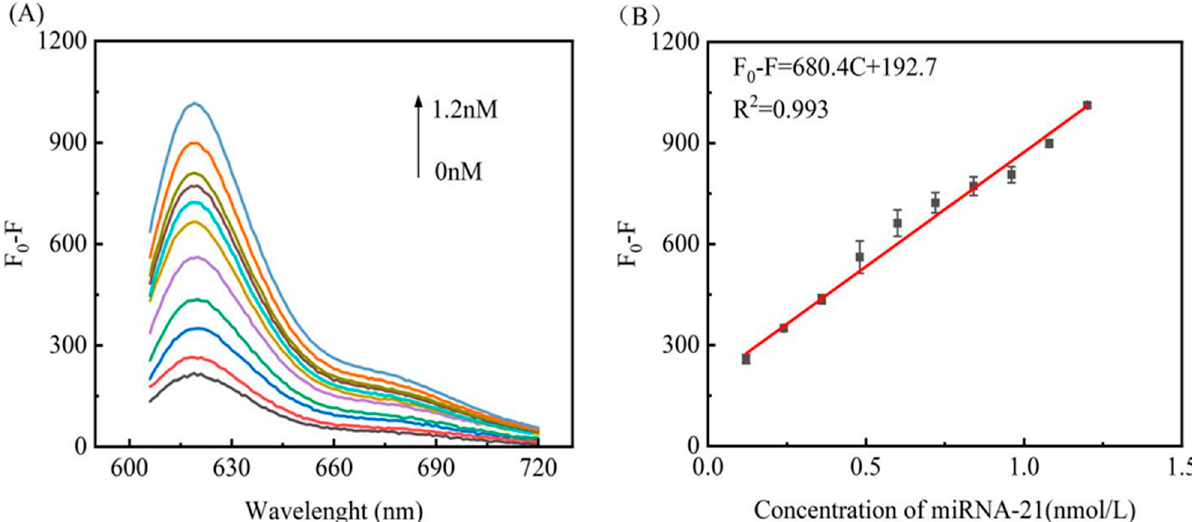
Figure 5. ( A ) Fluorescence emission spectra of miRNA-21 at different concentrations. The curves from the bottom to the top represent 0.0 nM, 0.12 nM, 0.24 nM, 0.36 nM, 0.48 nM, 0.60 nM, 0.72 nM, 0.84 nM, 0.96 nM, 1.08 nM, and 1.20 nM targets. ( B ) Linear relationship of F 0 – F and the concentra- tion of miRNA-21 in the range of 0.12–1.2 nM. The error bars represent the standard deviation of triplicate measurements.